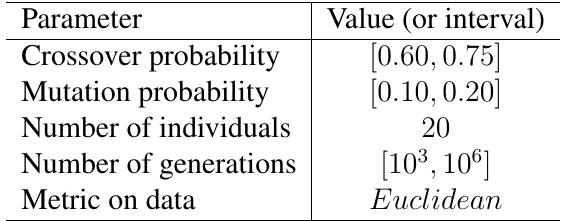
Table 1: Parameter settings to evaluate EMHC on the lung data